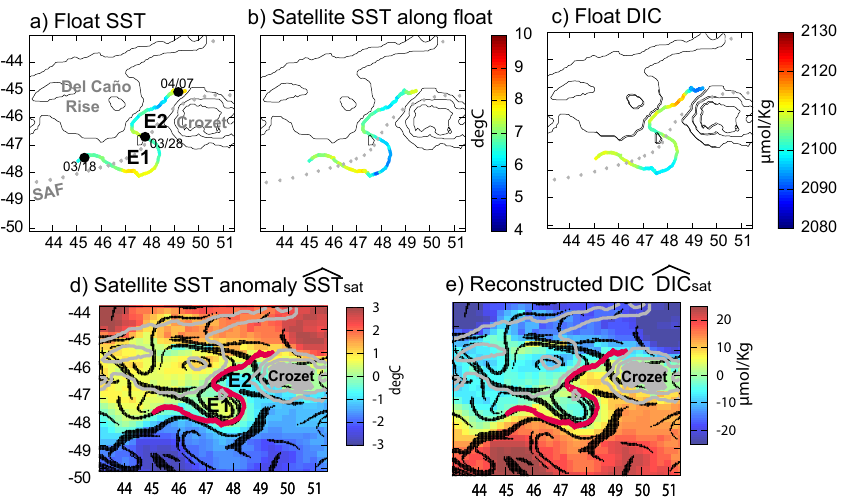
Fig. 9. Case study: (a) SST measured by drifter 13060 between 18 March and 7 April 2007; (b) satellite AMSR SST collocated in time and space with the drifter; (c) DIC measured by drifter 13060; (d) SST anomaly from satellite AMSR d SST sat on 28 March 2007 and (e) d DIC sat on 28 March 2007 reconstructed from d SST sat and a DIC–SST linear relationship derived from drifter measurements ( d DIC = − 9 . 69 · d SST + 0 . 09, with r 2 > 0 . 86). Dynamical boundaries derived from altimetry, i.e., unstable manifolds, are indicated in black (d’Ovidio et al., 2004). The drifter trajectory (in red) is wrapped around two eddies, denoted E1 and E2. Grey contours indicate the